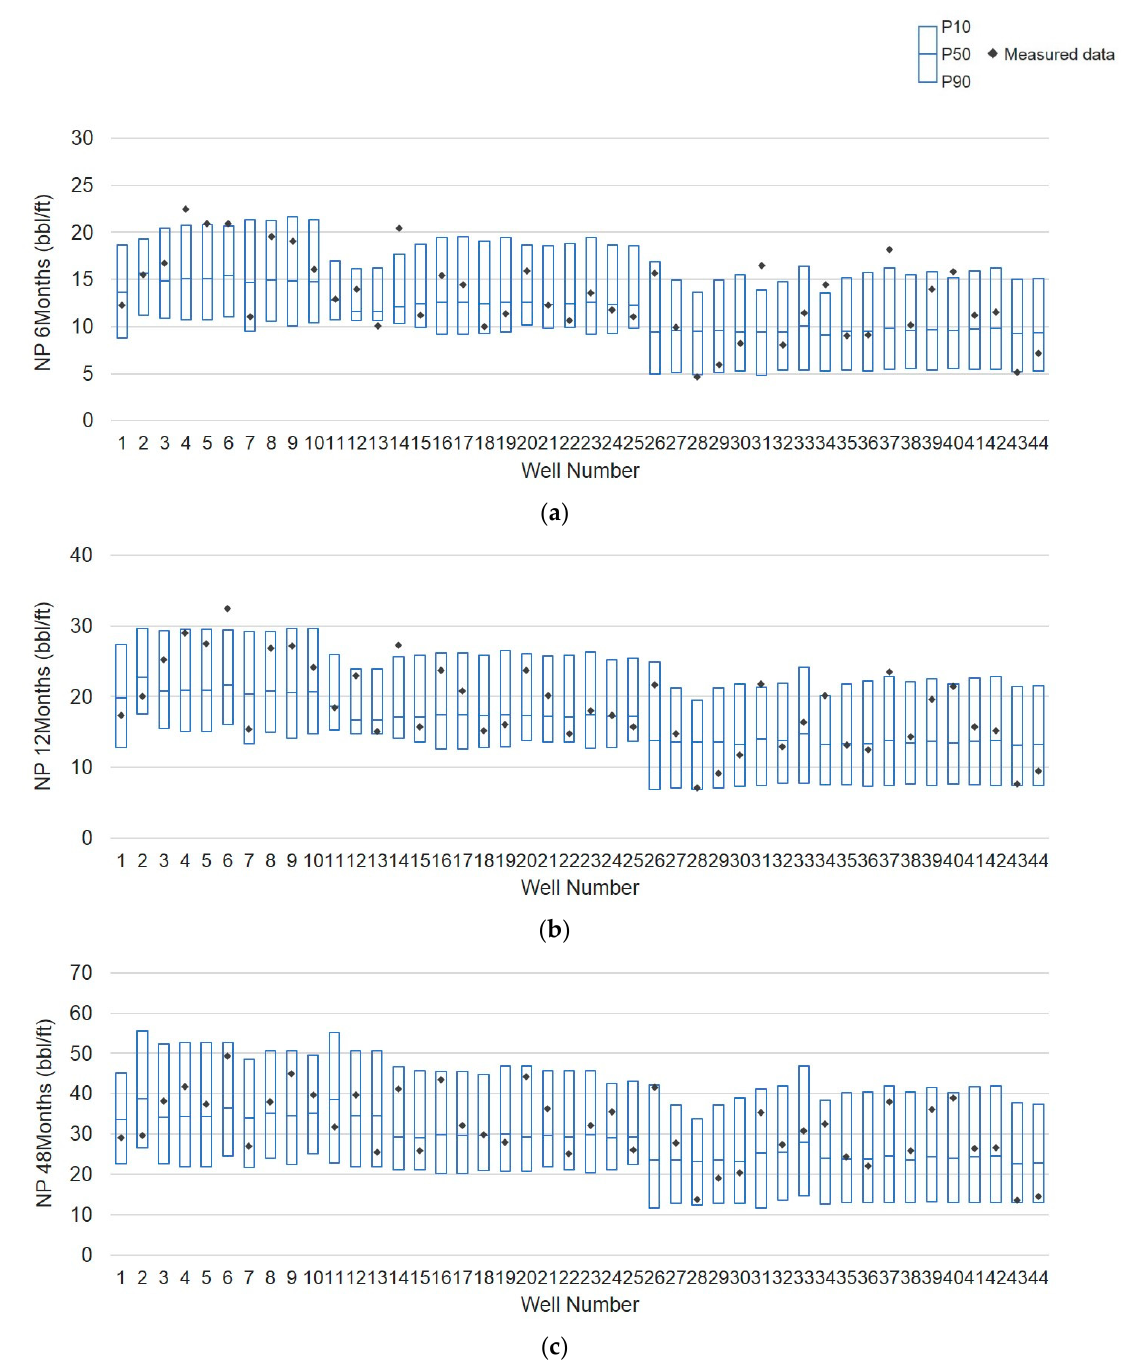
Figure 25. Prediction of the probabilistic production for new wells according to the production period: ( a ) NP 6; ( b ) NP 12; ( c ) NP 24.